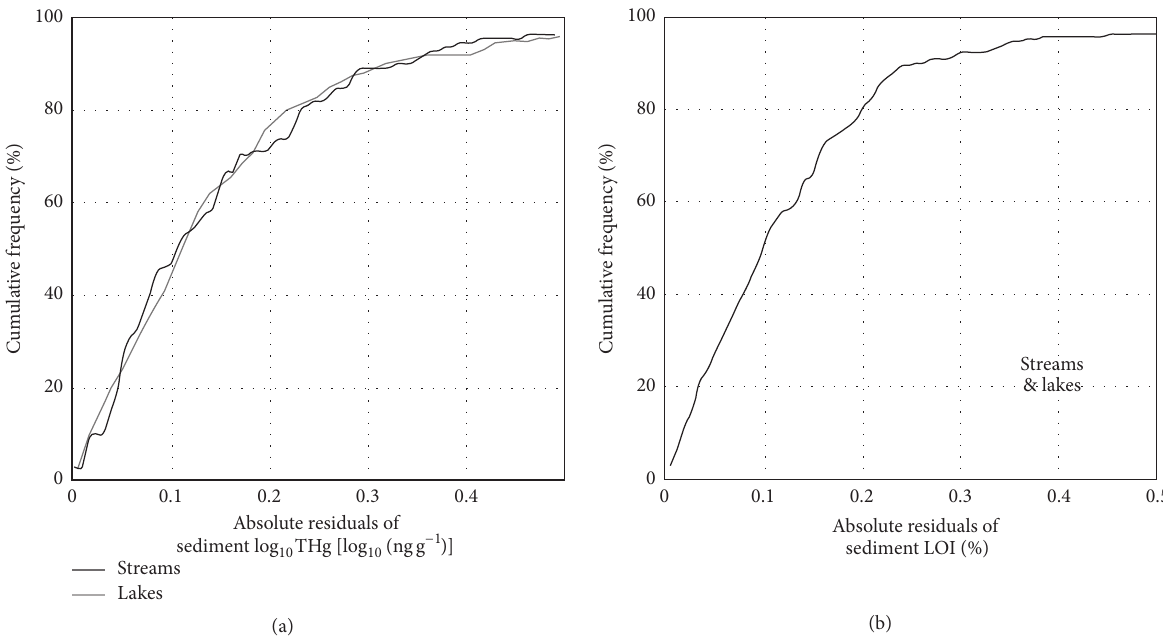
Figure 8: Conformance plots: cumulative frequency of the best-fitted absolute residual differences for stream and lake log 10 THg ([log 10 (ngg −1 )] (a)) and log 10 LOI (b) between (i) the NTS-tile averaged dots and (ii) the corresponding equations (2)–(4) projected map values in Figure